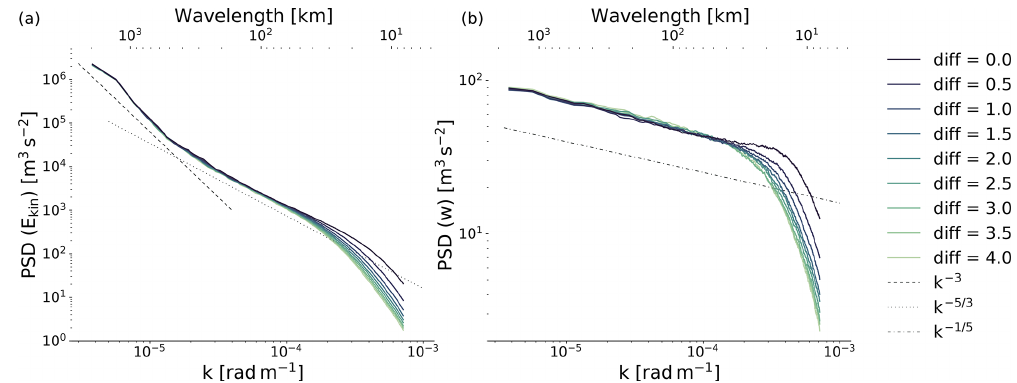
Figure 11. Power spectral density (PSD) plots for horizontal kinetic energy and w at 500hPa for runs with COSMO 2.2km and different values for explicit horizontal diffusion of wind, temperature, pressure, and moisture variables. Note the different scales on the vertical